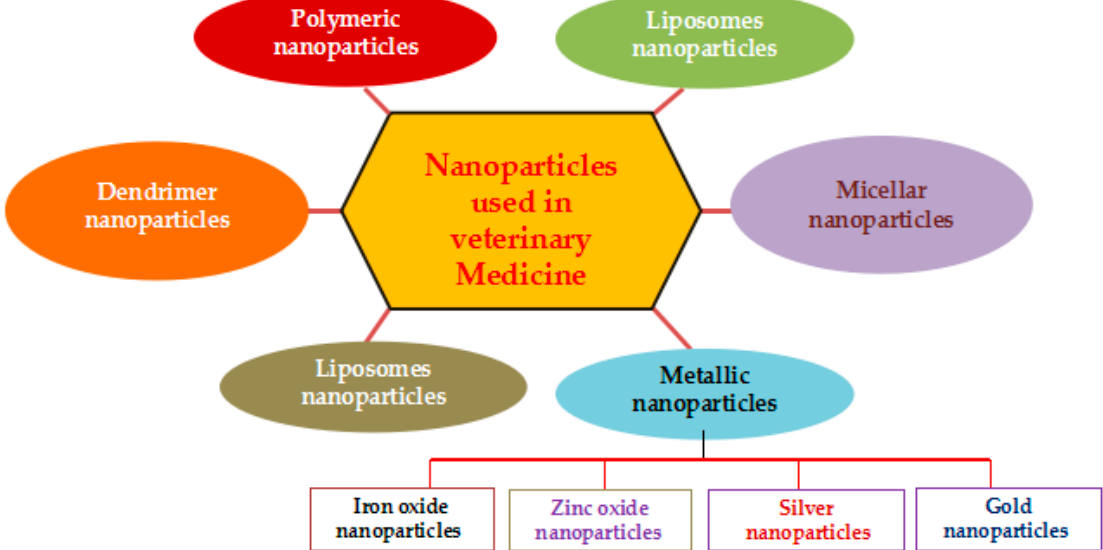
Figure 1. Type of nanoparticles used in application of veterinary medicine and animal production.